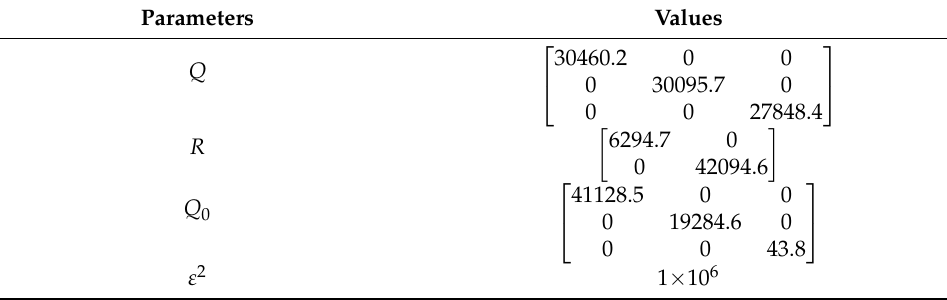
Figure 10. RMSE value of the motion State while tracking a double shift trajectory. Table 3. Parameters of circular trajectory